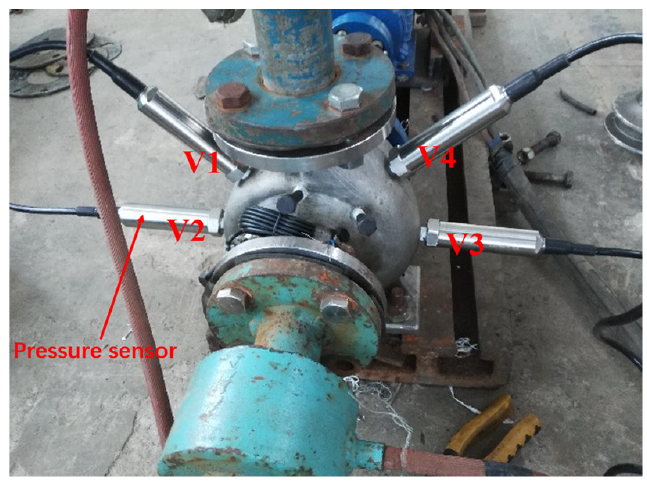
Figure 4. Pressure sensors distribution.